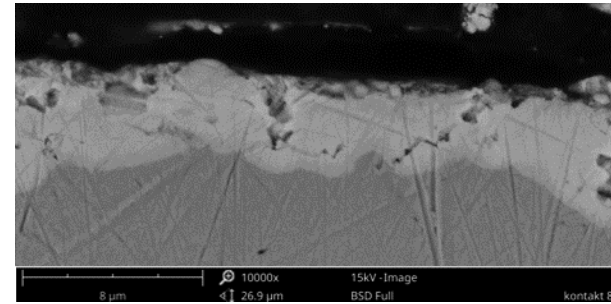
Fig. 8. Scanning microscope image of sample number 5 – a continuous layer, with varied coating thickness, numerous